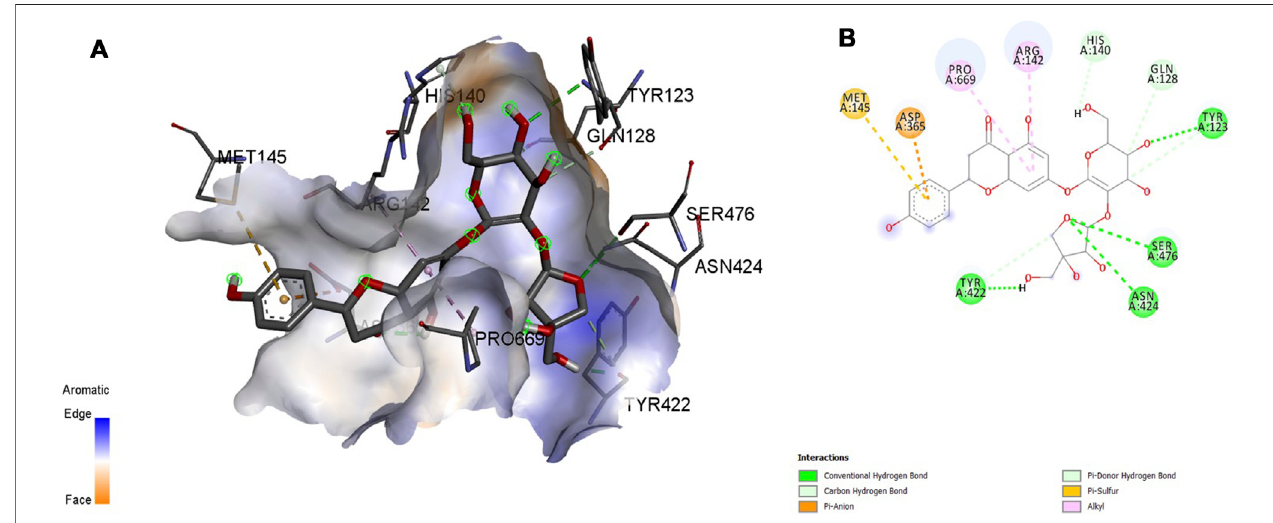
FIGURE 9 | Molecular docking interaction analysis of protein 3PFQ, (A) : 3D interactions and (B) : 2D interactions have been represented between 3PFQ-Apiin complex structures.